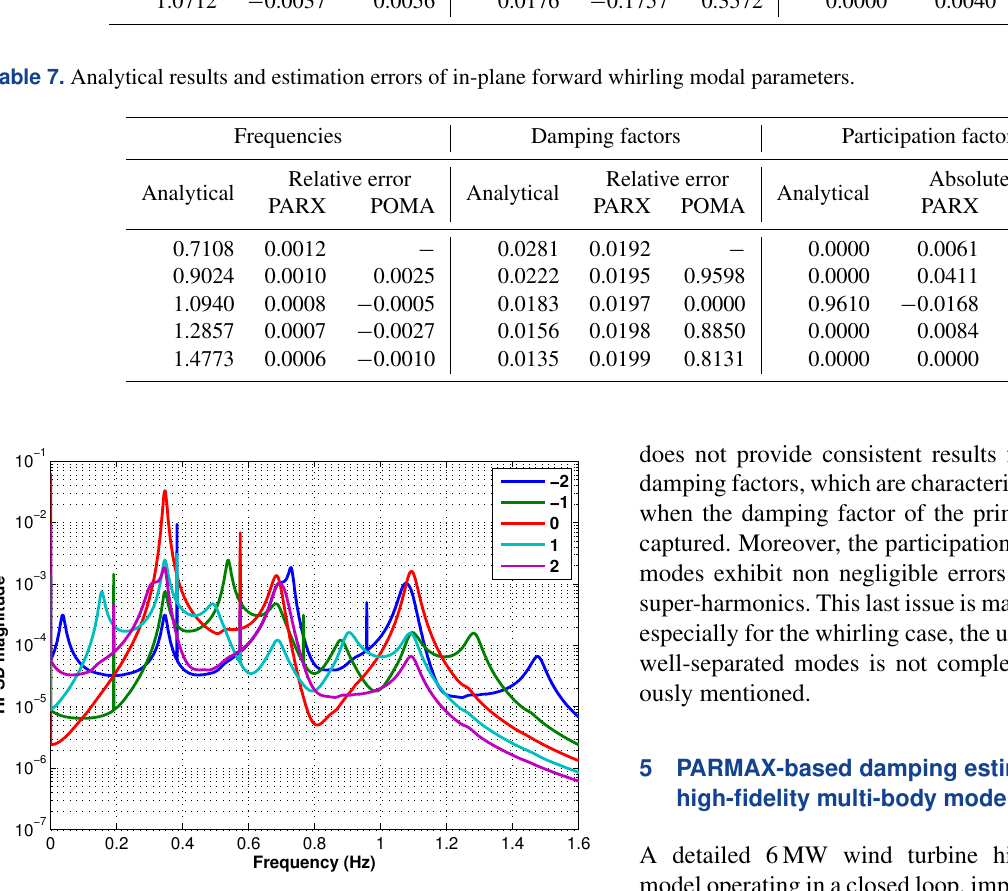
Figure 3. Harmonic power spectrum of the y H output of the wind turbine analytical model. Three modes are visible on the n = 0 curve, along with the rotational frequency and its